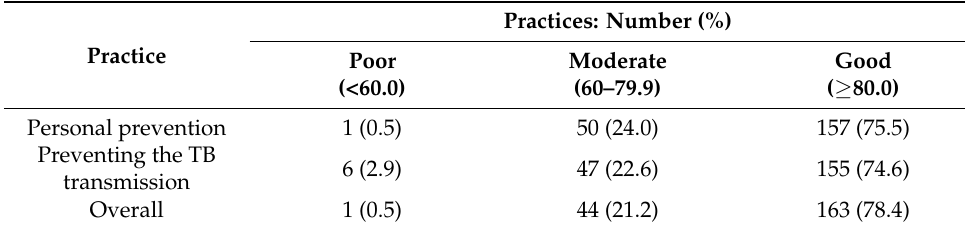
Table 3. Practices for TB prevention and control.